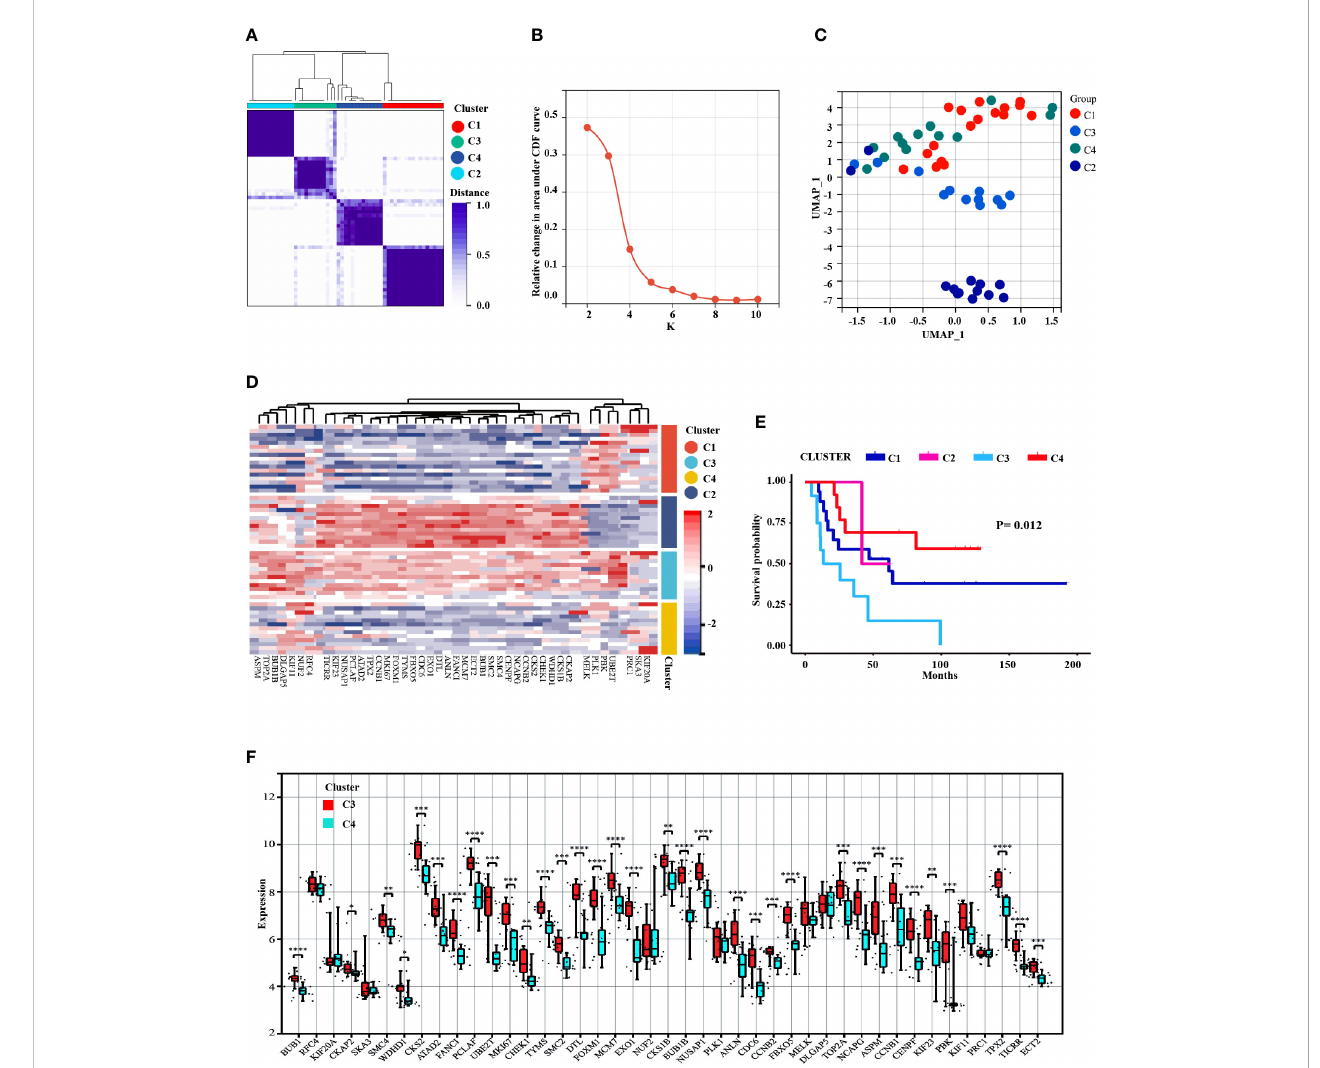
FIGURE 6 Prognosis identi fi cation of ES patients by clustering analysis based on MCODE-DEGs expression pro fifi le. (A) Consensus clustering divided into 4 subgroups. (B) The CDF curve showed the consistency of clustering (K=2 the highest consistency, followed by K4). (C) UMAP dimension reduction analysis testi fi ed the classi fi cation. (D) The heat map displayed the different expression patterns of the MCODE-DEGs in 4 clusters. (E) The survival analysis of ES patients found signi fi cant differences among the four subgroups, P <0.05. (F) Boxplot revealed difference expression status of the MCODE- DEGs between C3 and C4 (* P <0.05, ** P <0.01, *** P <0.001, **** P